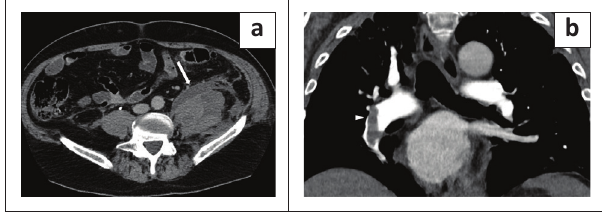
FIGURE 3: A 65-year-old man with multiple haematomas, the first diagnosed 22 days after hospital admission. (a) Axial plane, venous phase: haematoma (arrow) in the left psoas muscle. (b) Coronal plane, pulmonary arterial phase: endoluminal filling defect in the right pulmonary artery (arrowhead). The patient underwent endovascular treatment and survived.